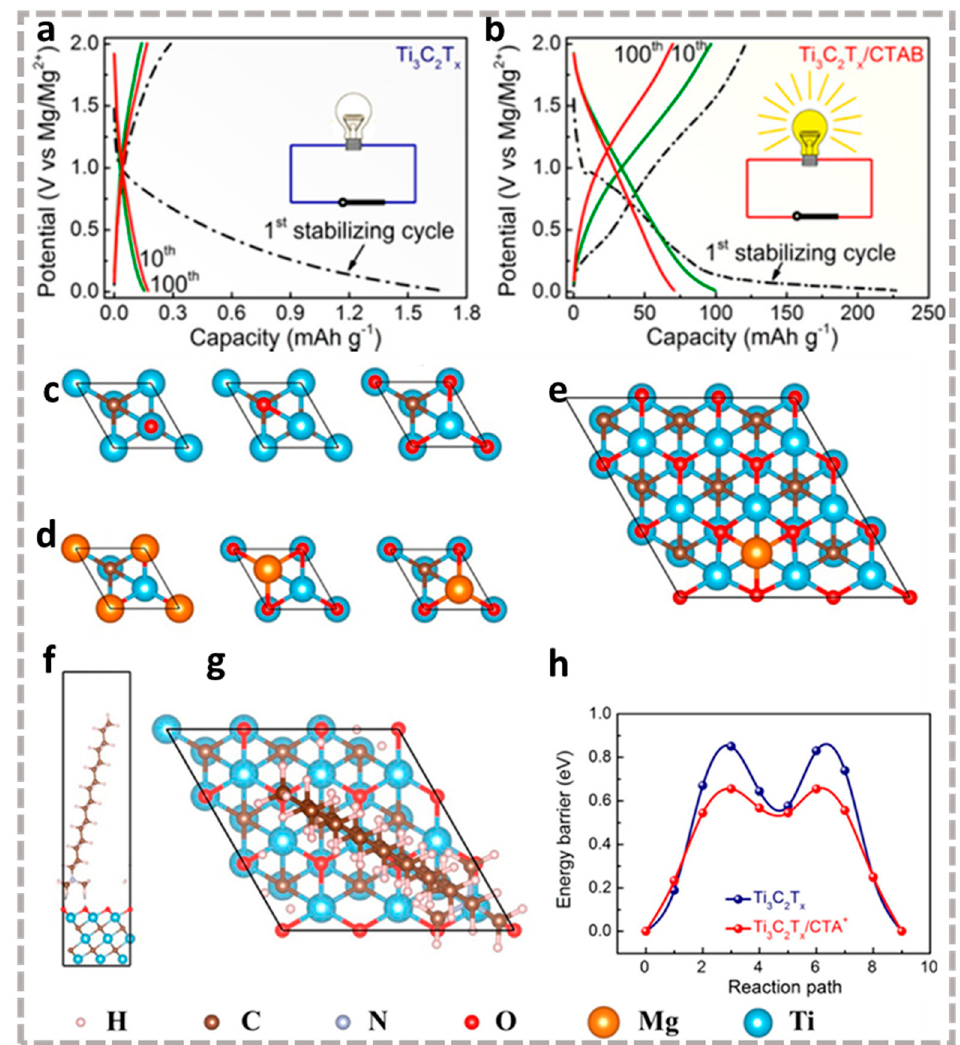
Figure 6. Galvanostatic charge/discharge (GCD) curves of ( a ) Ti 3 C 2 T x and ( b ) Ti 3 C 2 T x /CTAB electrode at di ff erent cycles at 0.05 A g − 1 ; Top view of the structures for ( c ) an O atom and ( d ) a Mg atom adsorbed on 1 × 1 Ti 3 C 2 surface at the top site, body-centered cubic (bcc) site, and face-centered cubic (fcc) site, respectively. Top view of ( e ) Mg 2+ and ( g ) CTA + as well as ( f ) side view of CTA + adsorbed on the 3 × 3 Ti 3 C 2 O surface; ( h ) Di ff usion pro fi le of Mg 2+ on Ti 3 C 2 O and CTA + /Ti 3 C 2 O surface in nudged elastic band calculations [40]. Reproduced with permission from ACS Nano.